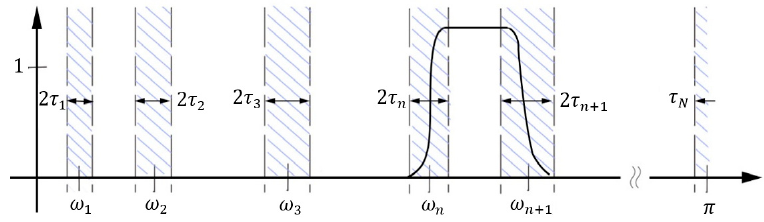
Figure 1. Illustration of spectrum segmentation by Empirical Wavelet Transform (EWT).